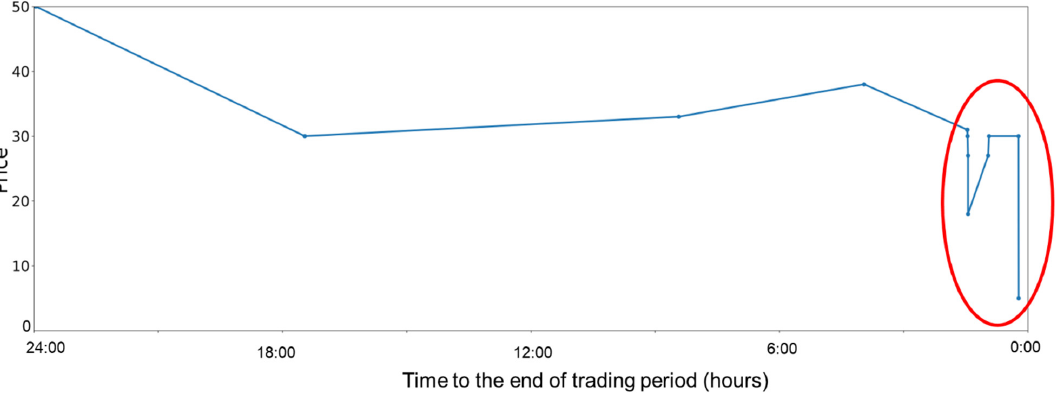
Figure 2. Example of large price fluctuations in the P2P electricity trading demonstration conducted in Japan. The horizontal axis denotes the time to the end of the trading period.